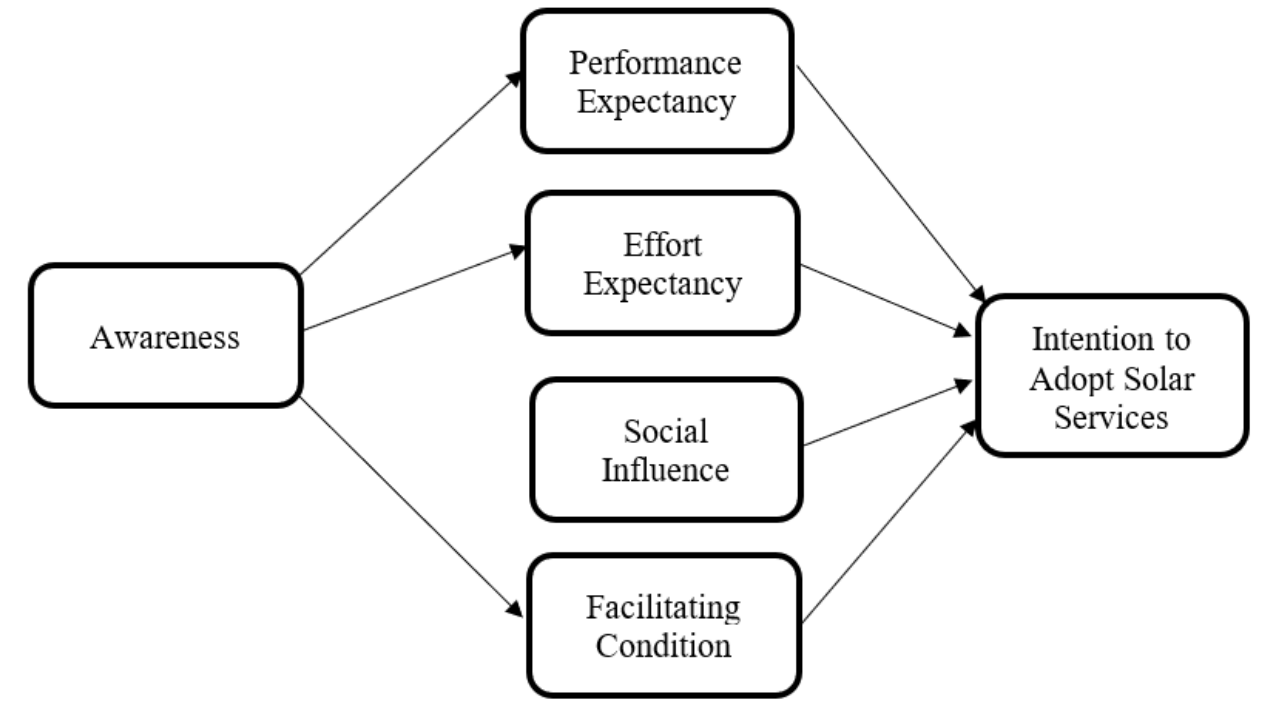
Figure 1. Schematic diagram of research model and its exogenous and endogenous variables.